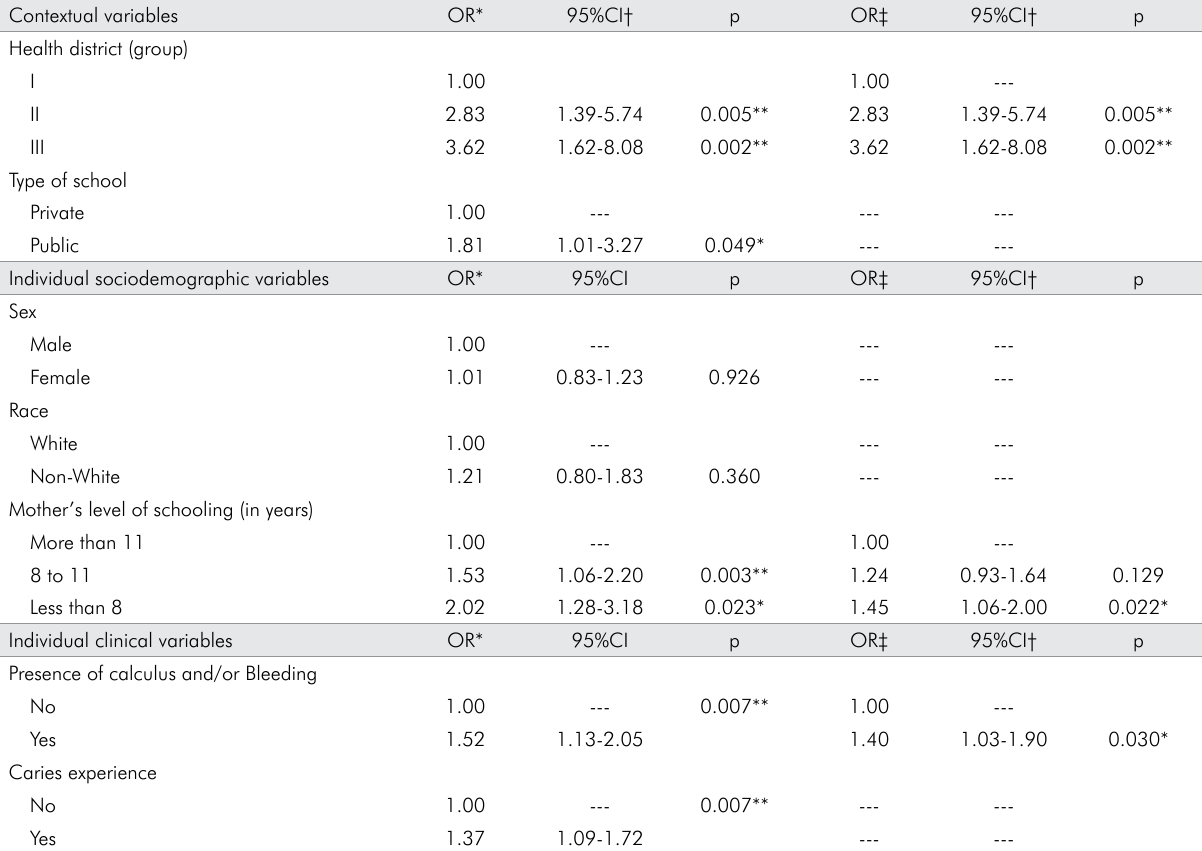
Table 2. Results of multilevel simple and multiple logistic regression for the prevalence of malocclusion (DAI > 25). 12-year-old schoolchildren, Goiânia, Brazil,